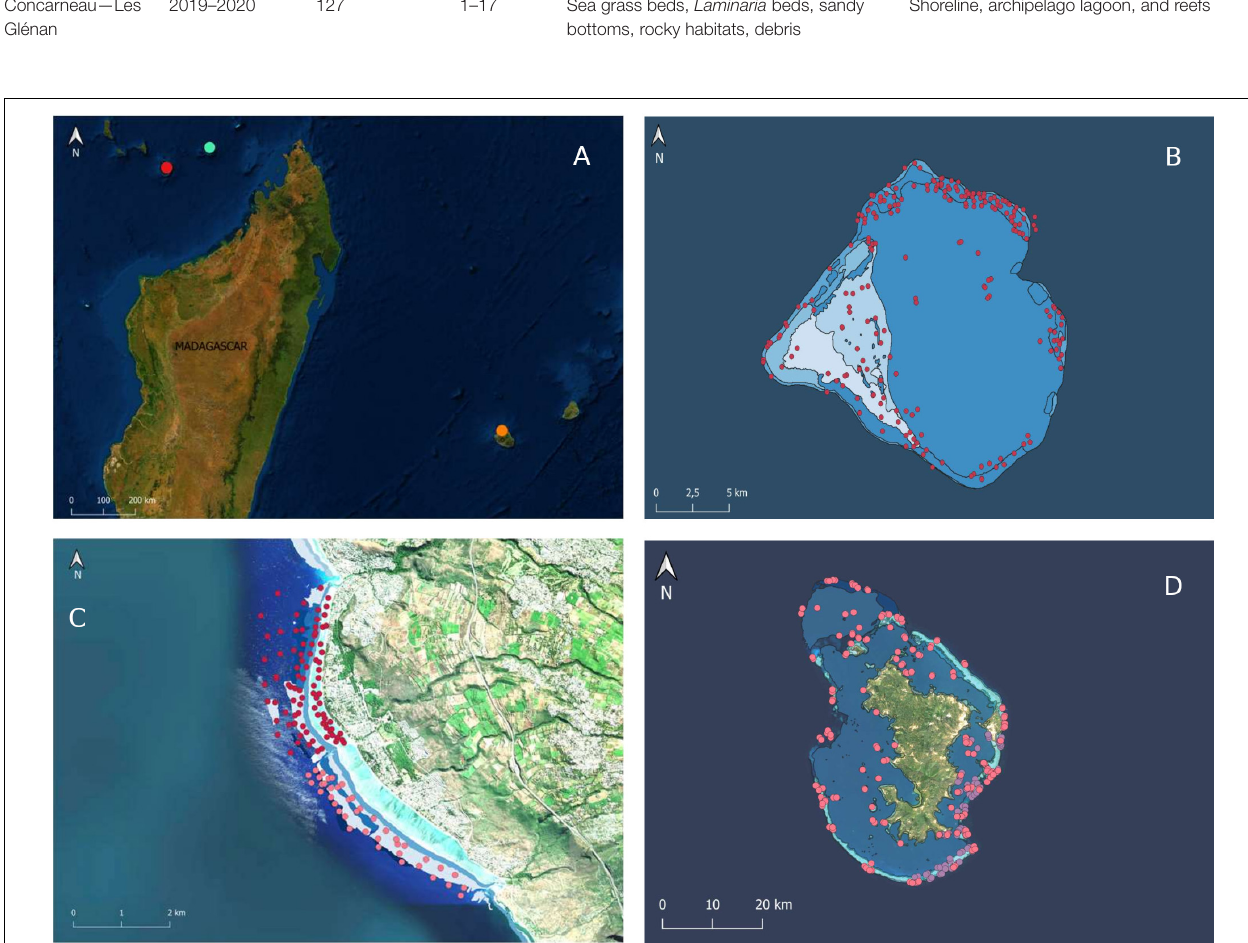
FIGURE 3 | Sampled sites in the Indian Ocean (A) [Geyser Bank (light blue); Mayotte (red) and Réunion Island (orange)], and sampled stations in Geyser Bank (B) , Réunion Natural Reserve (C) and Mayotte (D) . At the Réunion Natural Reserve (C) , sampling corresponds to 2016 (red) and 2017 (pink).